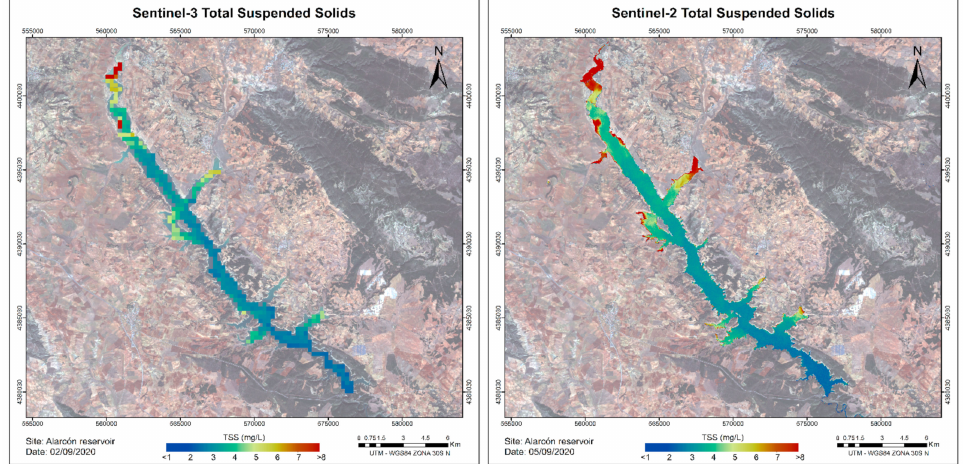
Figure A2. Thematic maps of TSS concentration for Alarc ó n reservoir using S3 (left) and S2 (right)